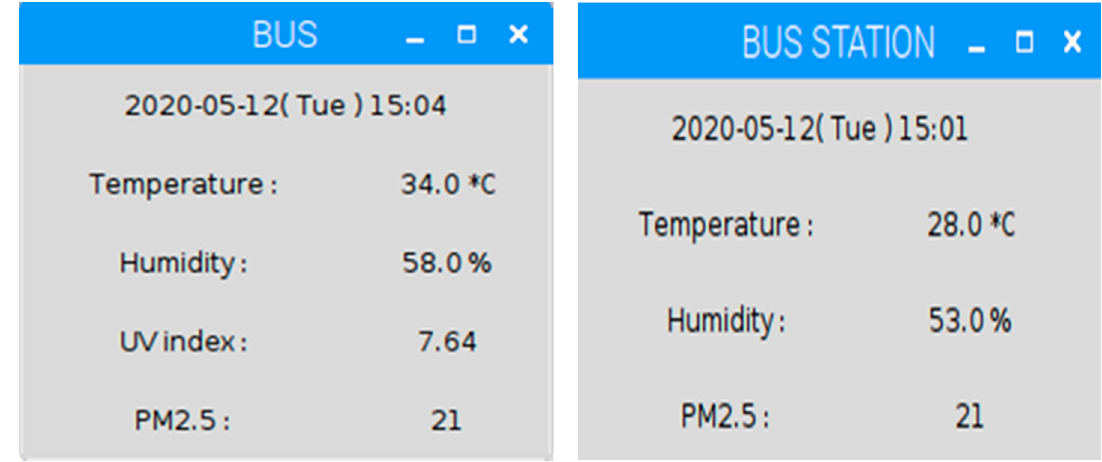
Figure 8. The weather information on the bus (left); environmental monitoring at the bus station (right).